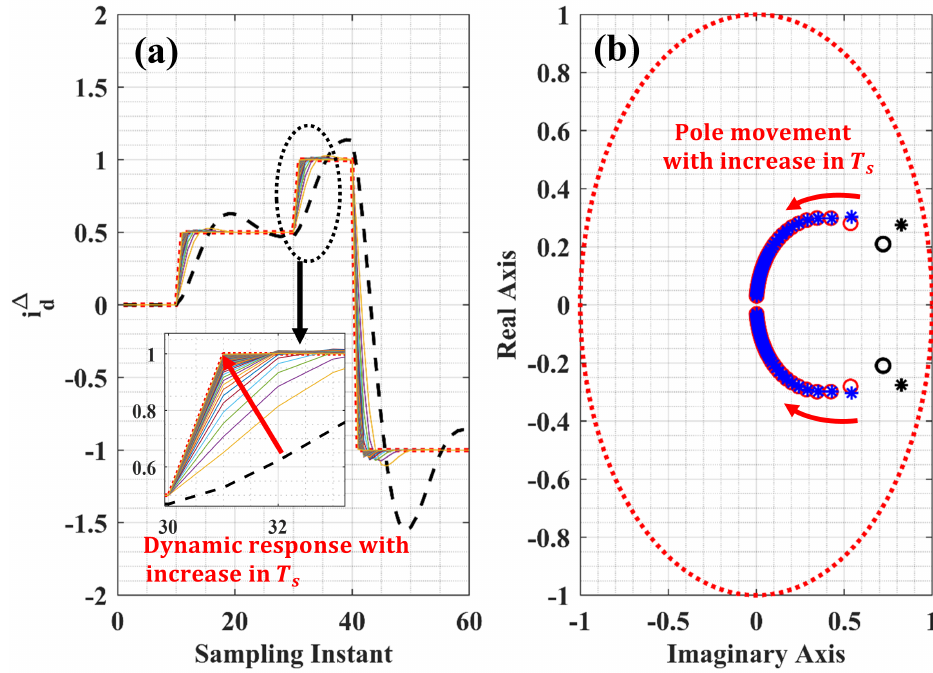
Figure 16. Effect of sample time ( T s ) on the dynamic response and